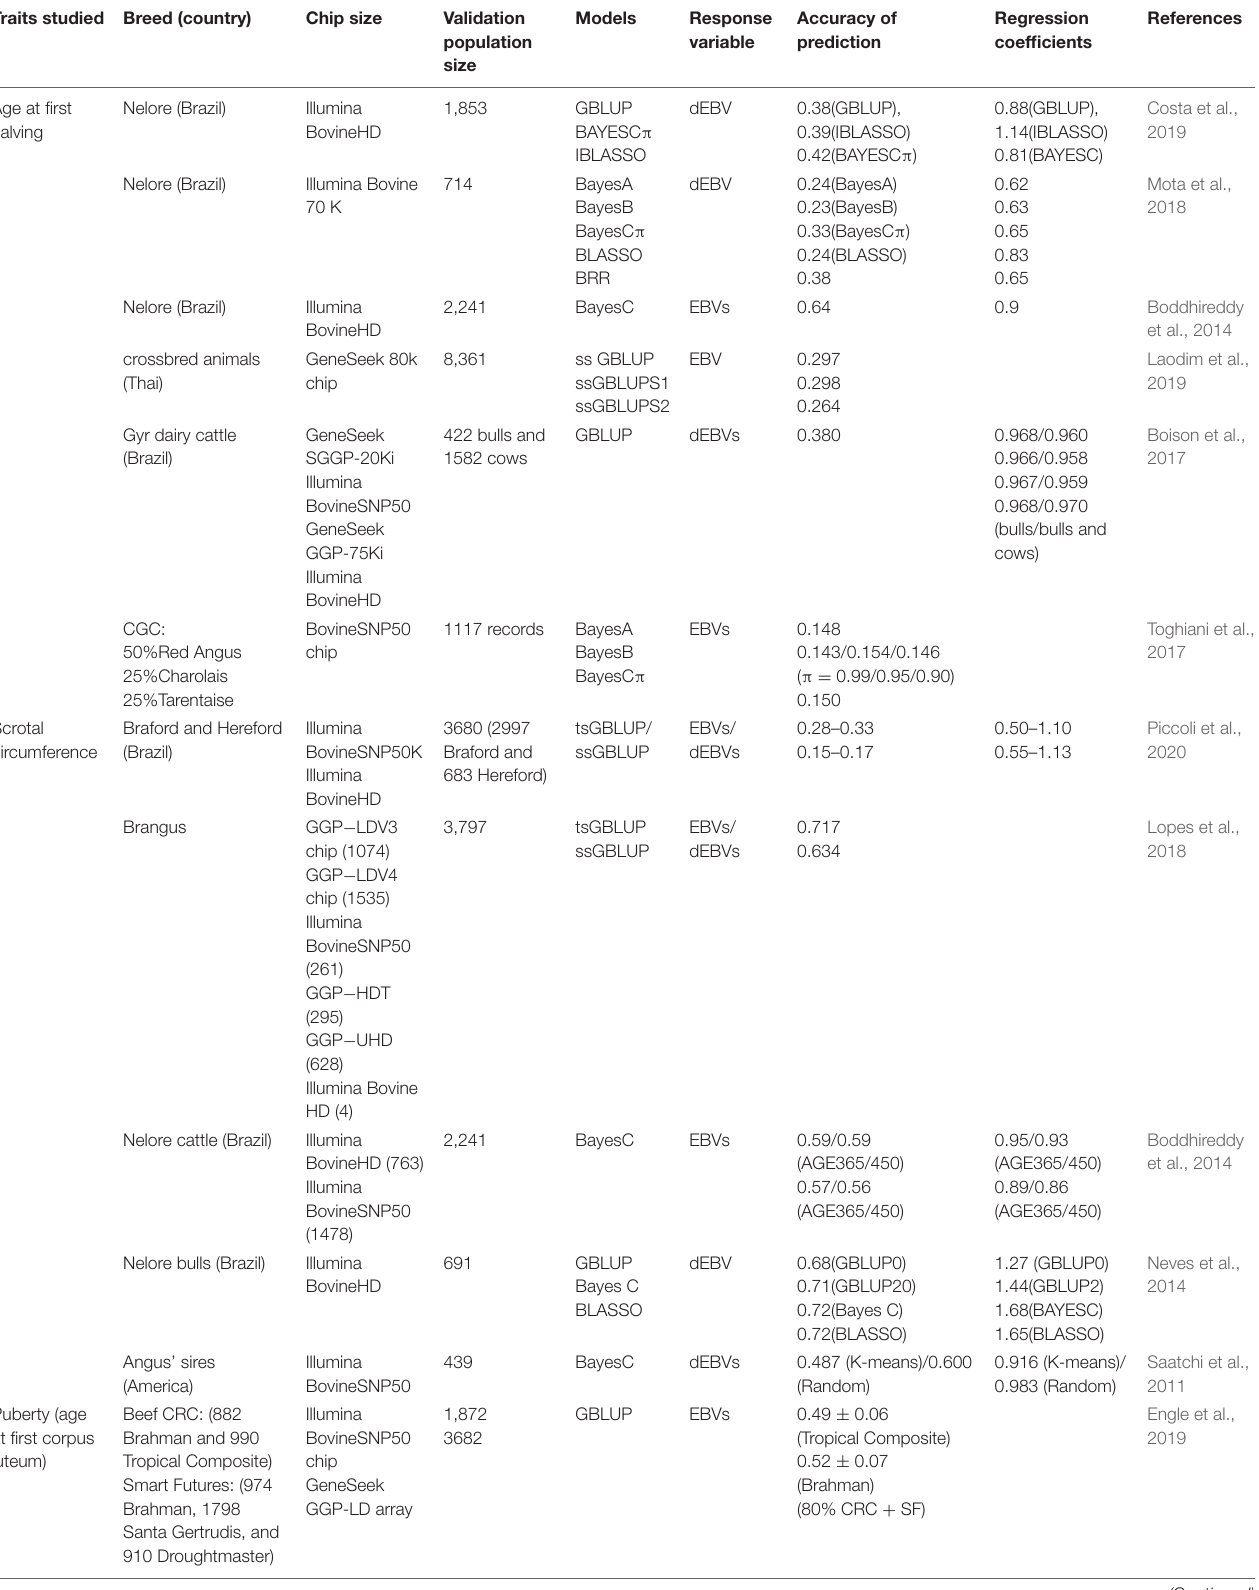
TABLE 5 | A summary of genomic selection studies for reproductive traits. Traits studied Breed